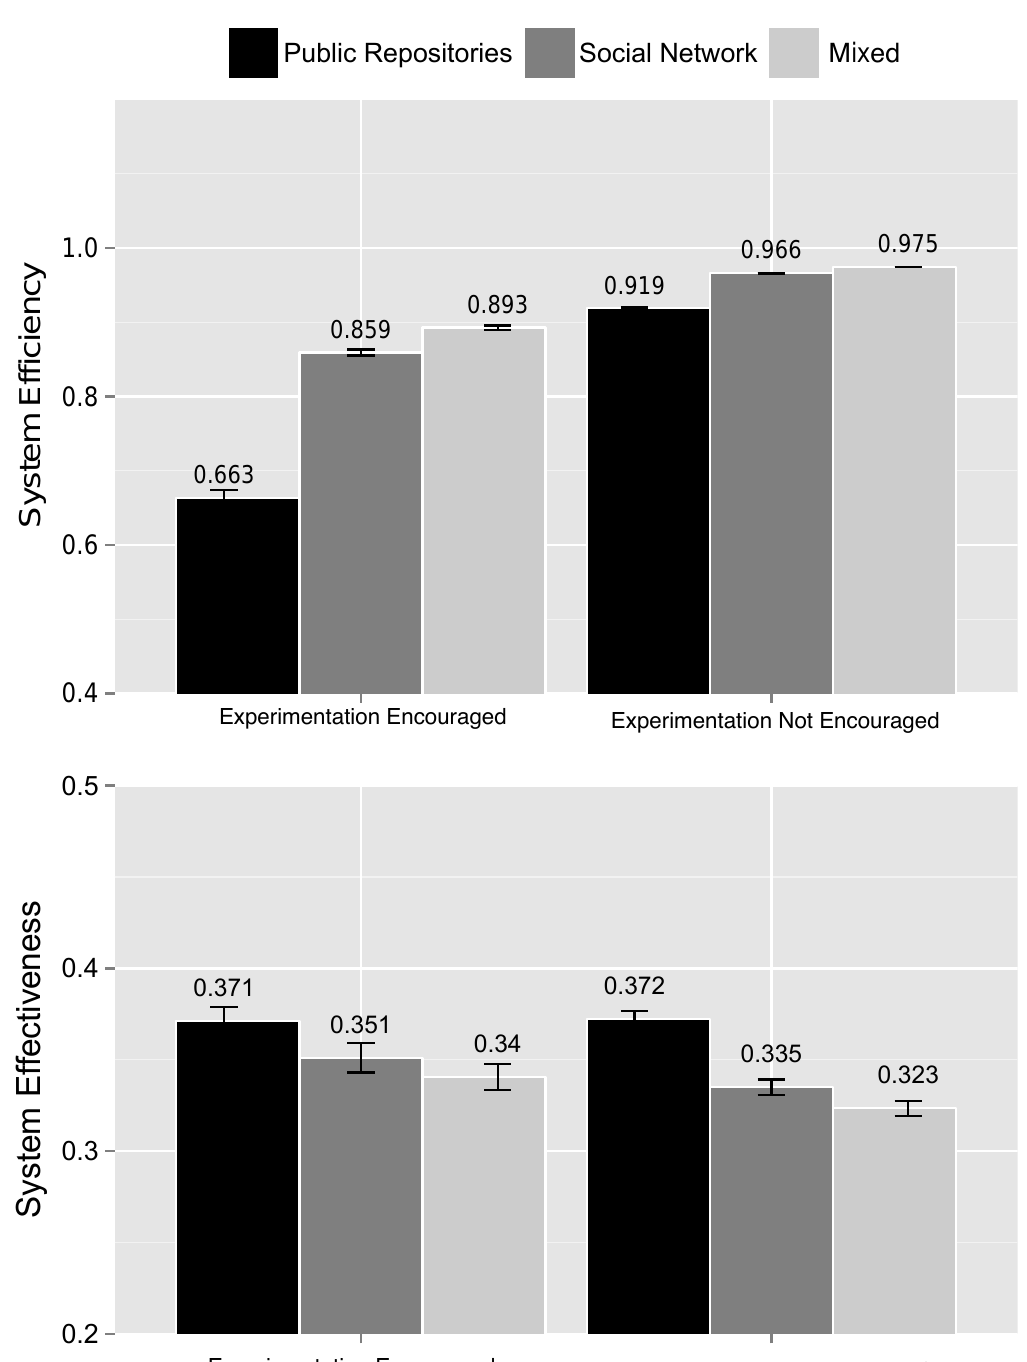
Figure 6: Effects of public repositories, social network, and mixed information on system efficiency and effectiveness in the knowledge transformation models when individual experimentation is encouraged versus when it is not encouraged. The maximum efficiency and effectiveness in both models are normalized to